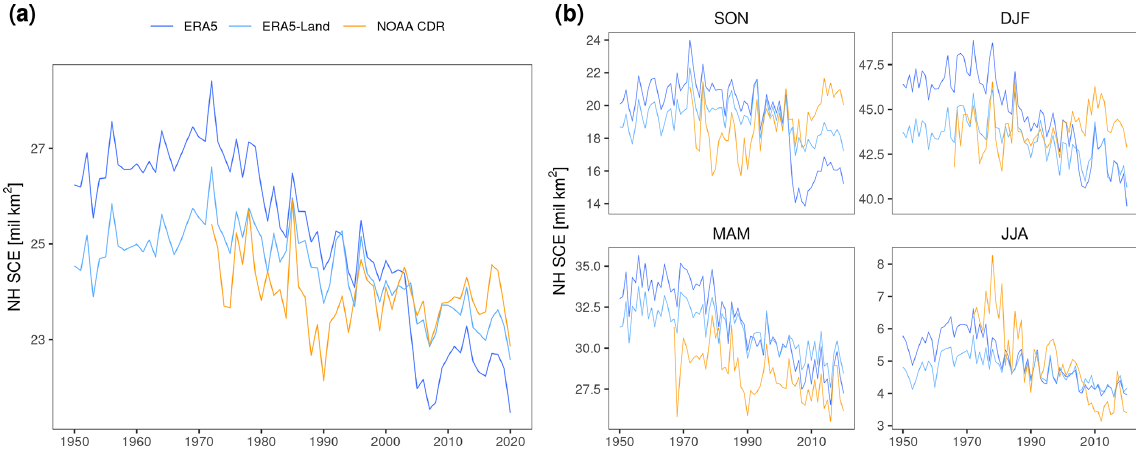
Figure 11. Annual ( a ) and seasonal ( b ) NH snow cover extent (SCE) [10 6 km 2 ].